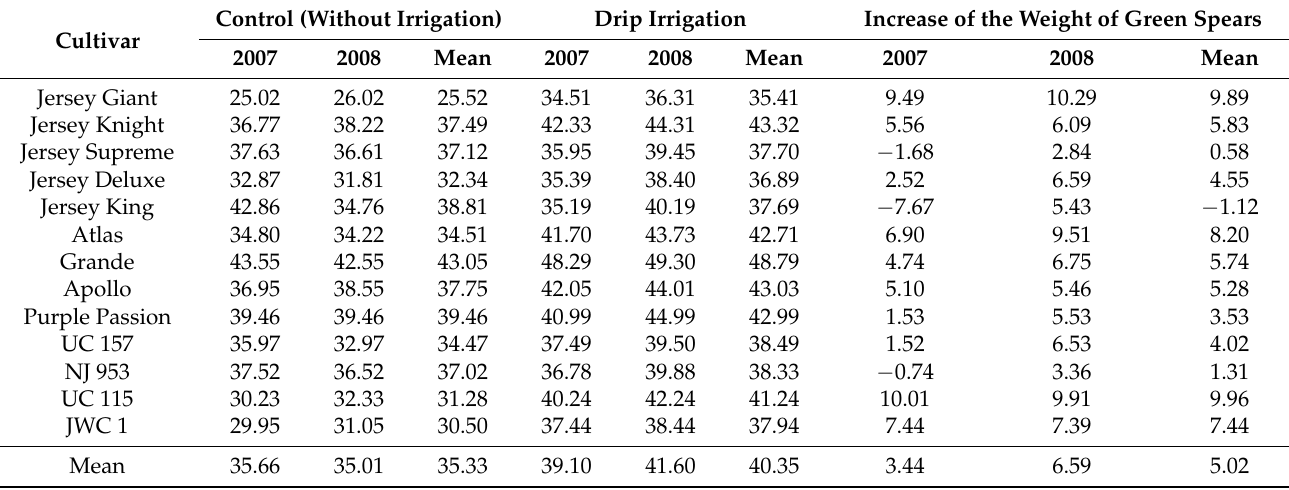
Table 11. Weight of the asparagus green spears (g) as dependent on cultivar and irrigation. Control (Without Irrigation) Drip Irrigation Increase of the Weight of Green Spears Cultivar 2007 Mean Jersey Giant Jersey Knight Jersey